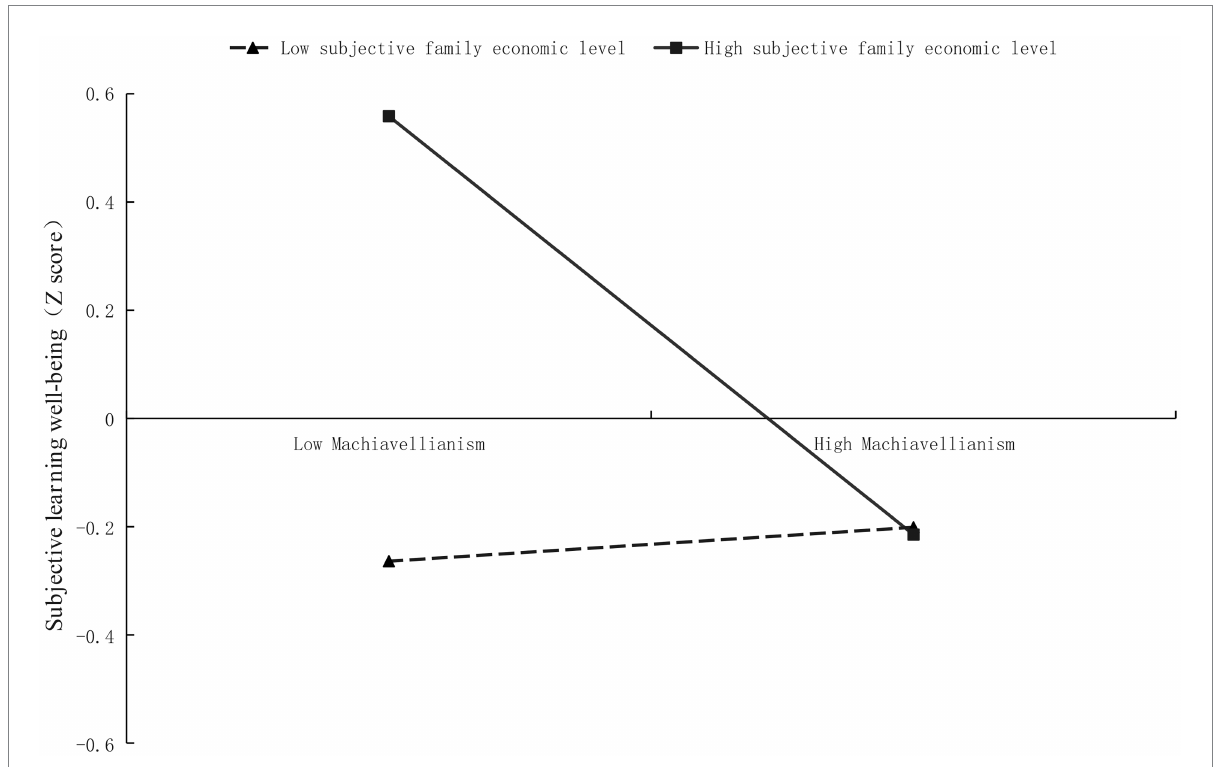
FIGURE 3 The interaction effect of subjective family economic level and Machiavellianism on learning-related subjective